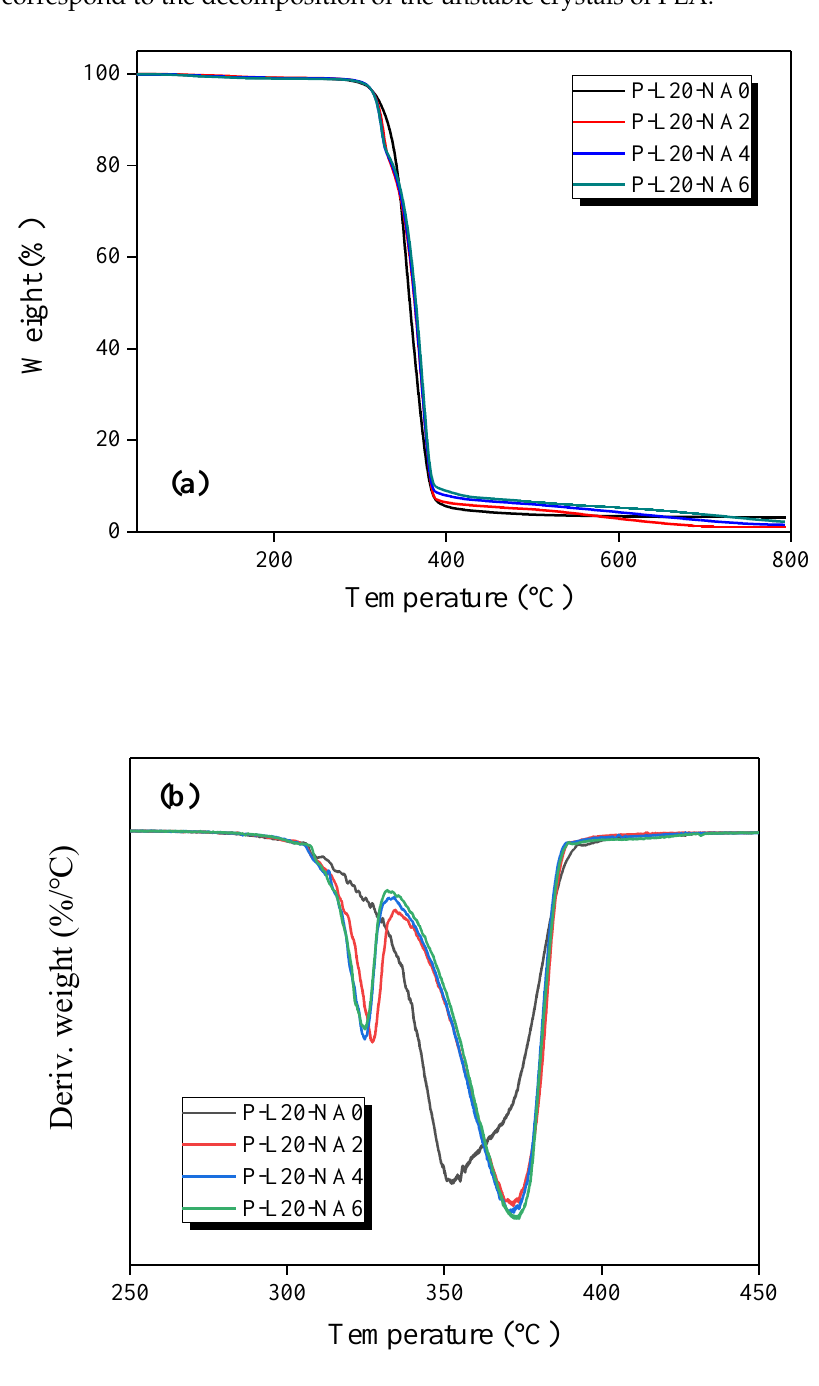
Figure 4. TGA ( a ) and DTG ( b ) thermograms of the NF-reinforced PLA composites with different NA contents.